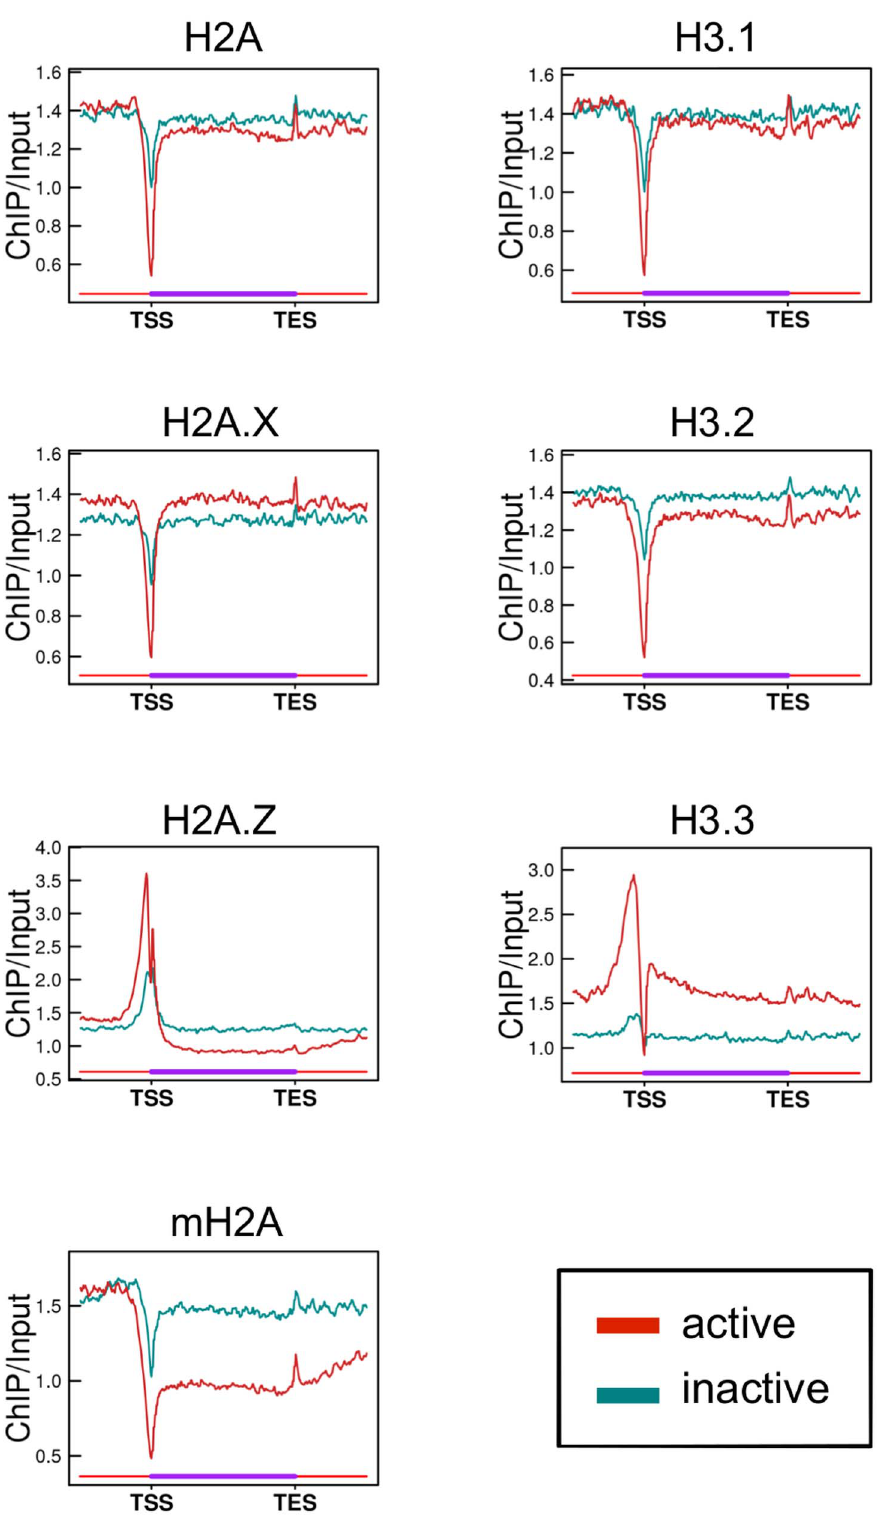
Figure 1. Enrichment of histone variants in active and inactive genes. Line graphs show the average enrichment (ChIP/input) of each histone variant in active (red) and inactive (dark cyan) genes. TSS and TES are the transcription start and end sites, respectively. The length of genes was normalized. In this analysis, genes of lengths , 4 kb were excluded, as overlapping TSS and TES vicinities after length normalization would result in inaccuracies in the data of the gene bodies. In addition, genes whose distance from neighboring genes was , 4 kb were also excluded to avoid overlapping of the flanking regions.